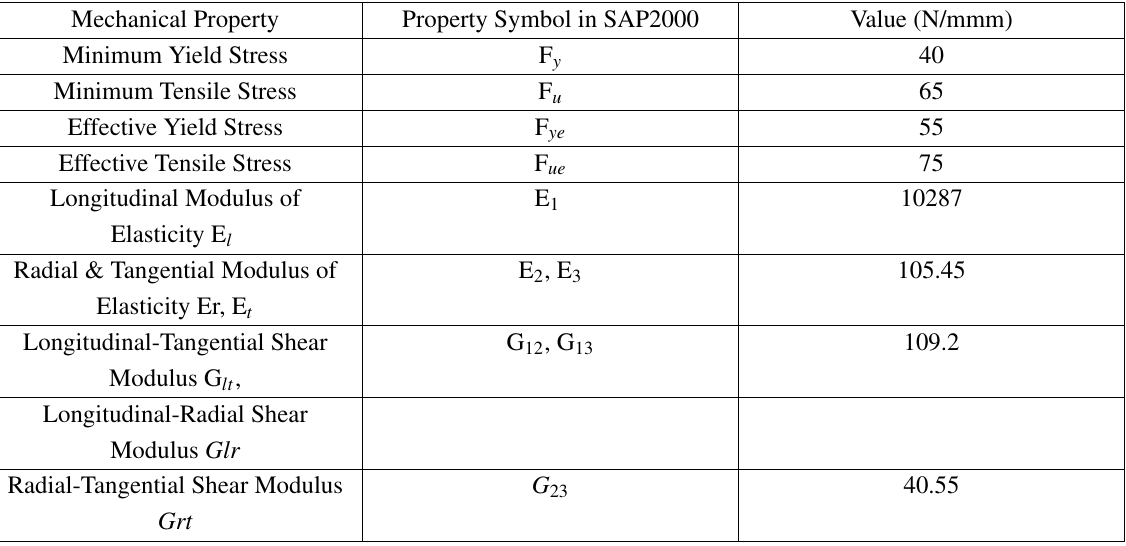
Table 2. The mechanical properties of date palm rachis baladi